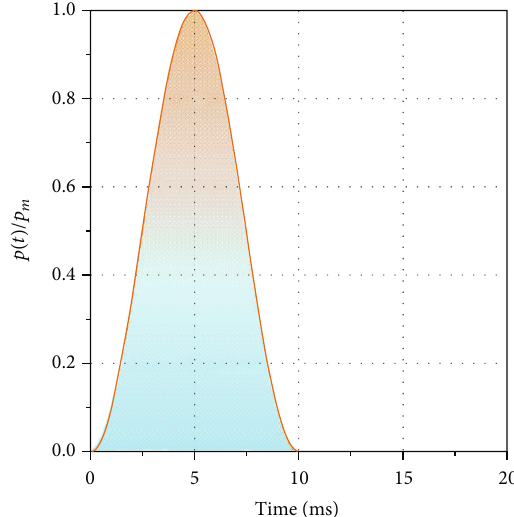
Figure 3: Blasting load loading curve.